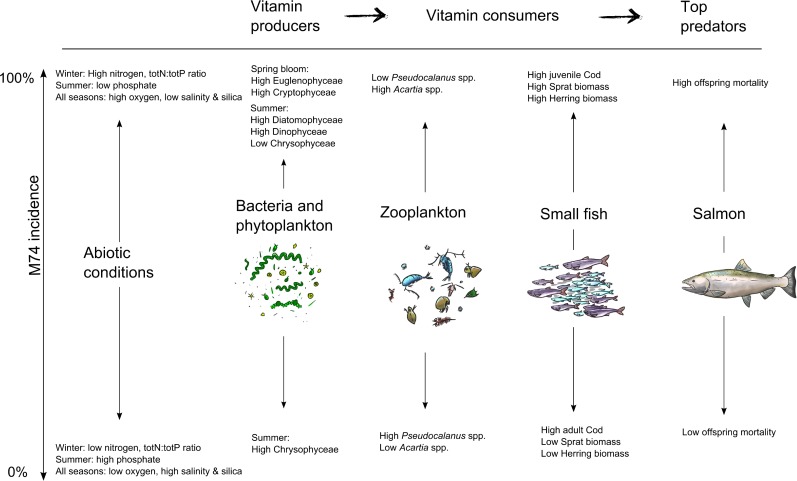
Schematic illustration of how salmon thiamin deficiency syndrome is strongly influenced by large-scale changes in the abiotic and biotic variables in the ecosystem.